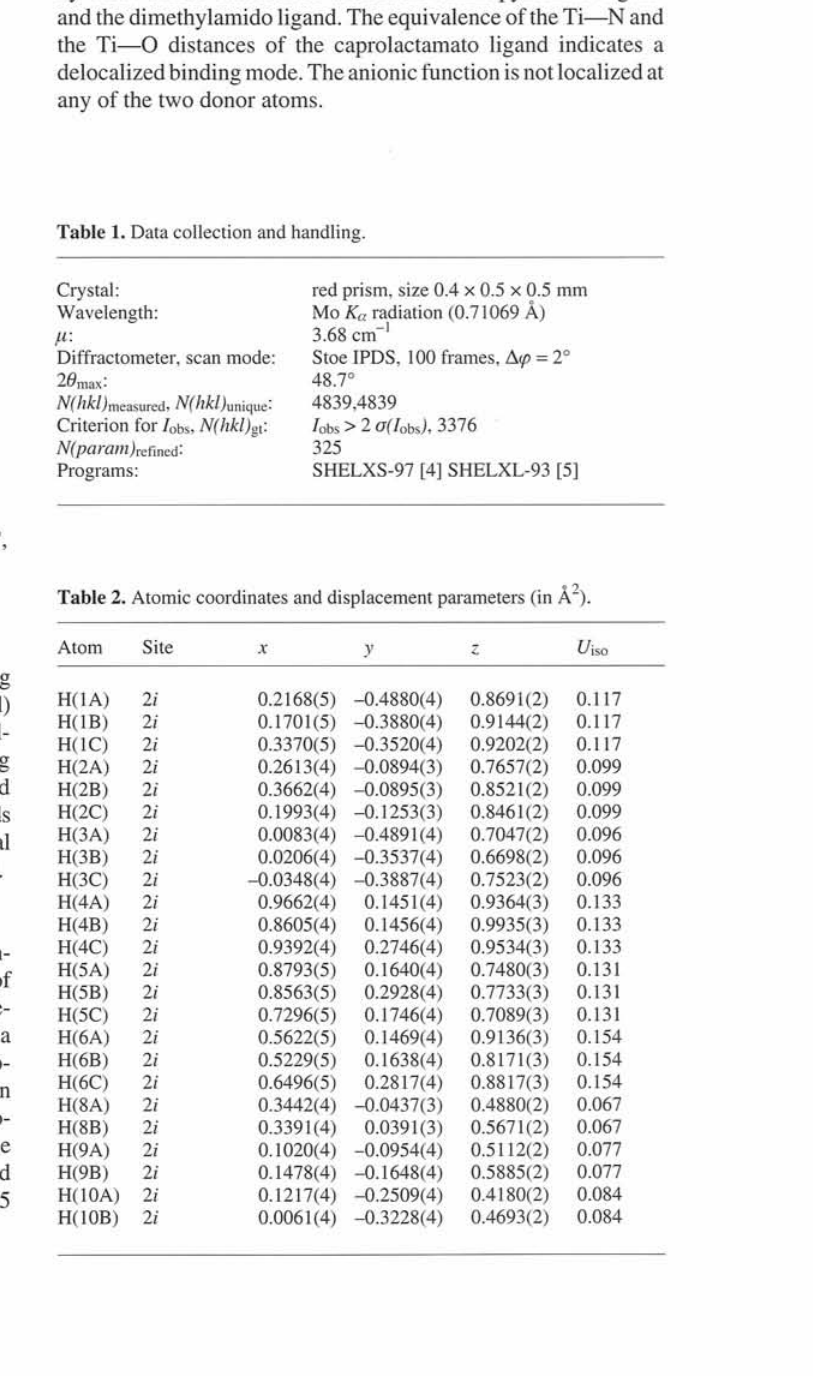
Table 1. Data collection and handling.